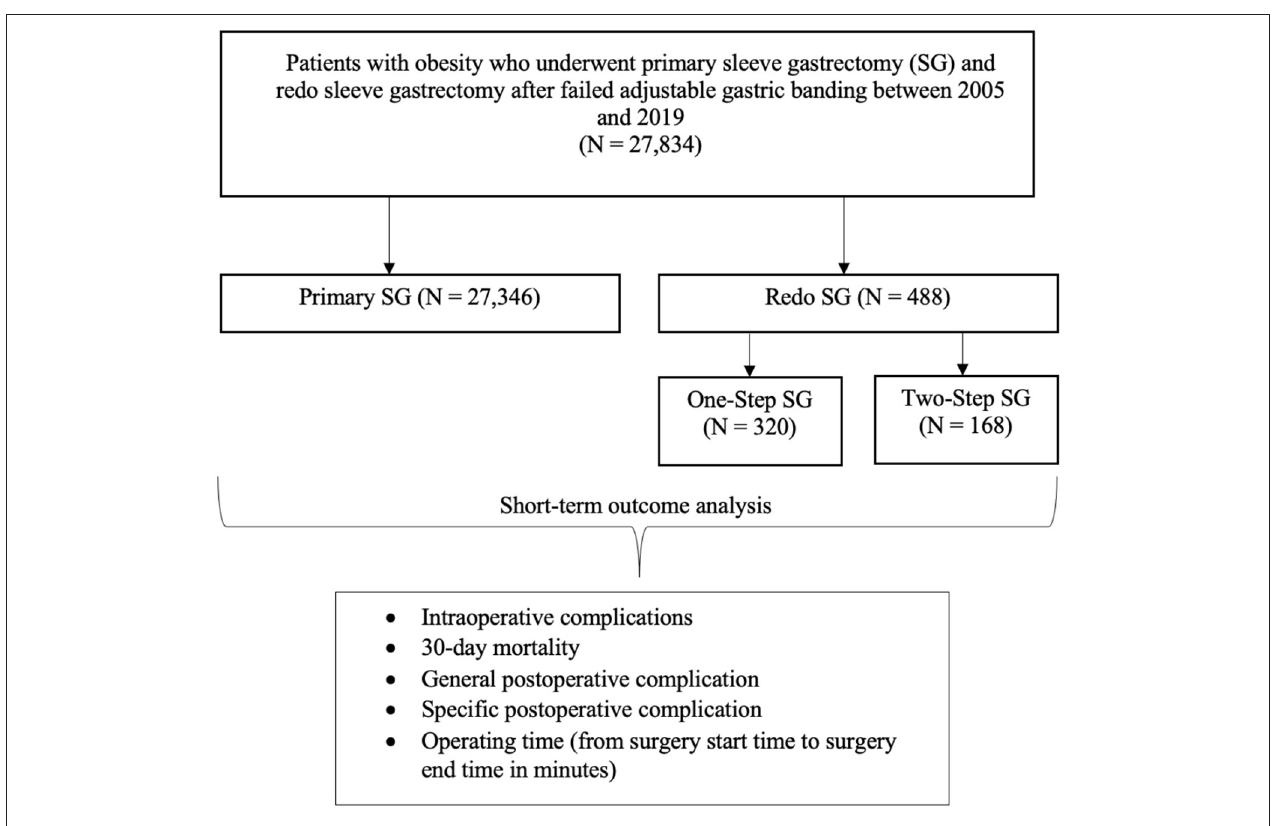
FIGURE 1 | Flowchart of patient inclusion.